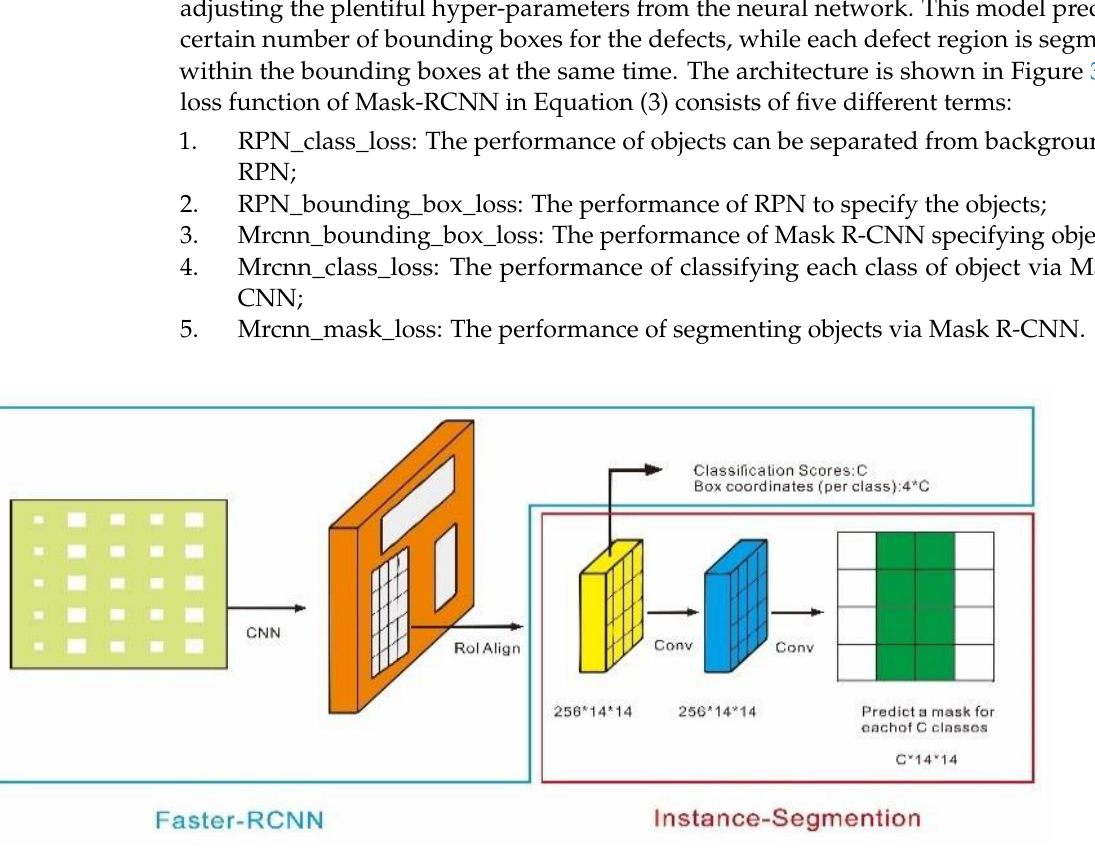
Figure 3. Mask-RCNN processing architecture [6].